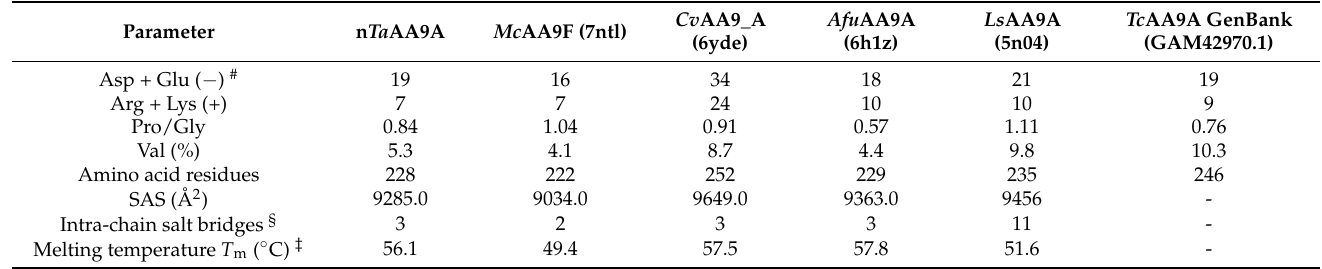
Table 2. Comparative statistics of thermostability parameters in AA9 LPMOs # .